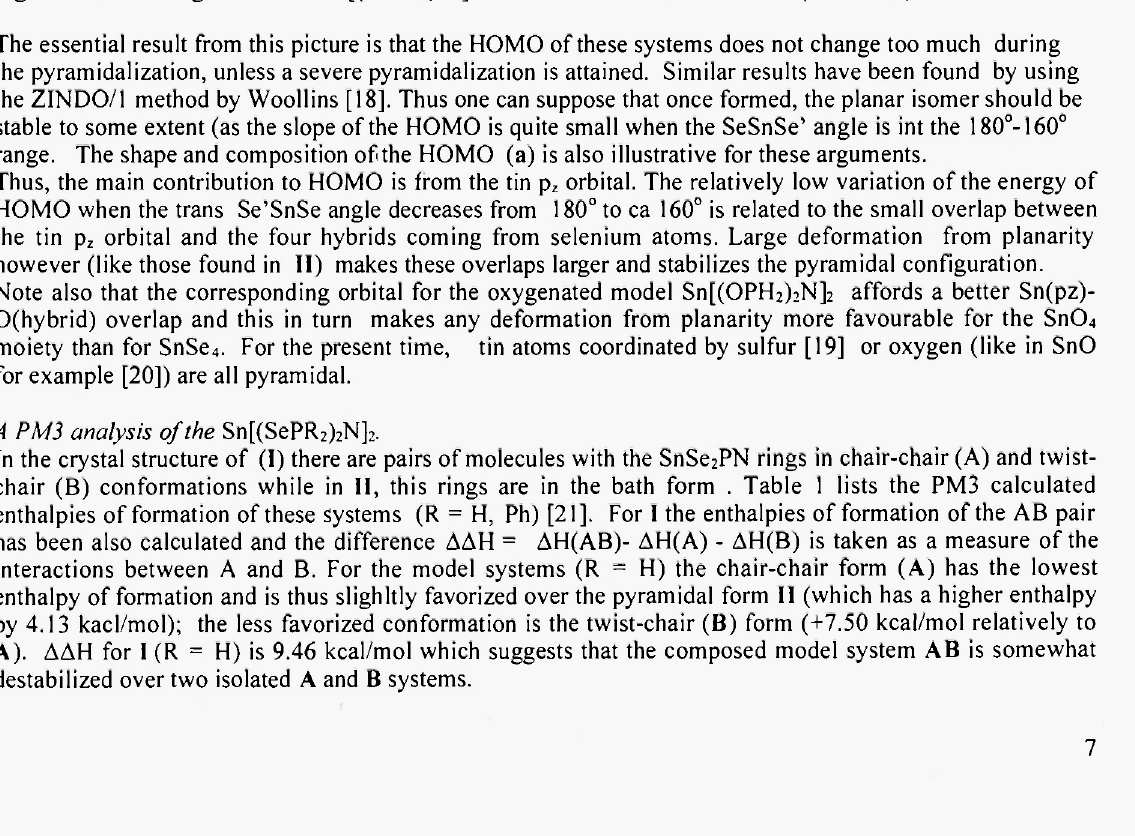
Figure 1. Walsh diagram for the Sn[(SePH 2 ) 2 N] 2 at fixed - 2.64Ä SnSe distance (see ref. 1